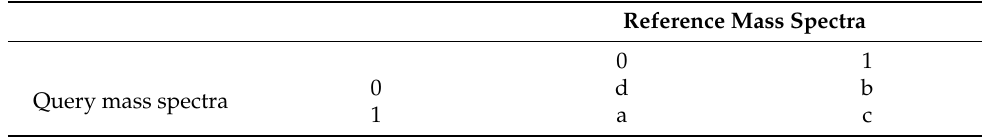
Table 3. A confusion matrix between binary query and reference mass